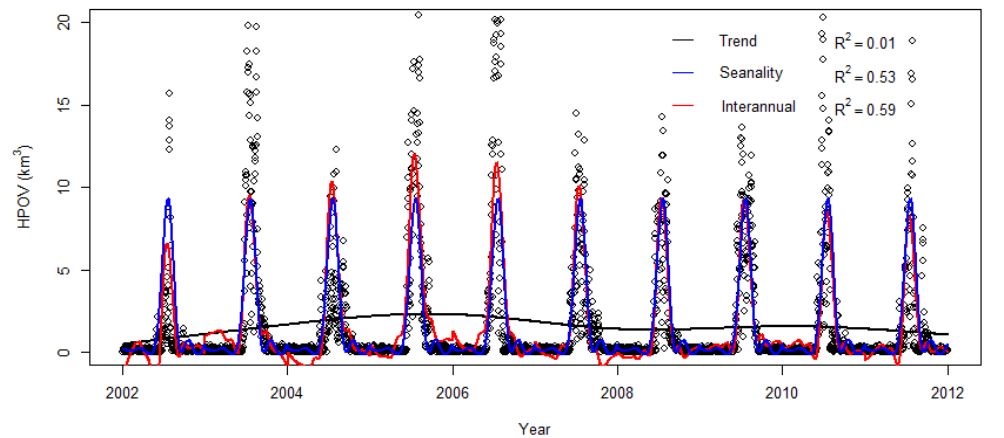
Figure 9. General Additive Model fitting to daily hypoxia volume. Dots: daily data; black line: trend ( y = gam(s(time, bs = ”cr”) ) where time is expressed in decimal years) “ cr ” indicates “cubic regression spline smooth”; blue line: seasonal variability ( y = gam(s(DOY, bs = ”cr”) ) where DOY stands as day of the year); red line: Interannual variability ( y = gam(s(time, bs = ”cr”) + s(DOY, bs = ”cr”) + ti(time, DOY, bs = ”cr”) ) where ti is the tensor product interaction function of time and DOY ).